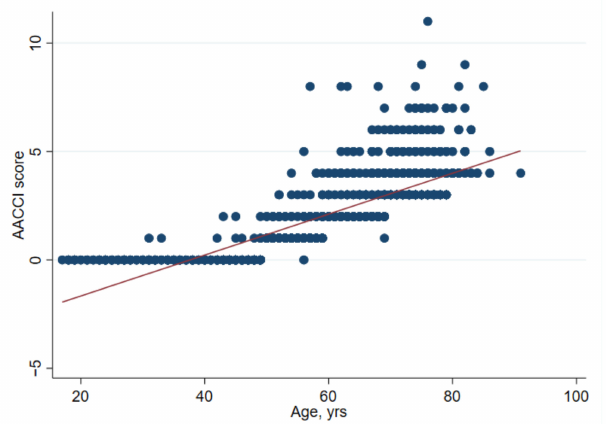
Figure 6. Correlation between age and the age-adjusted Charlston Comorbidity Index. This correla- tion is logical, as the score adds one point per 10 years after 50 years.